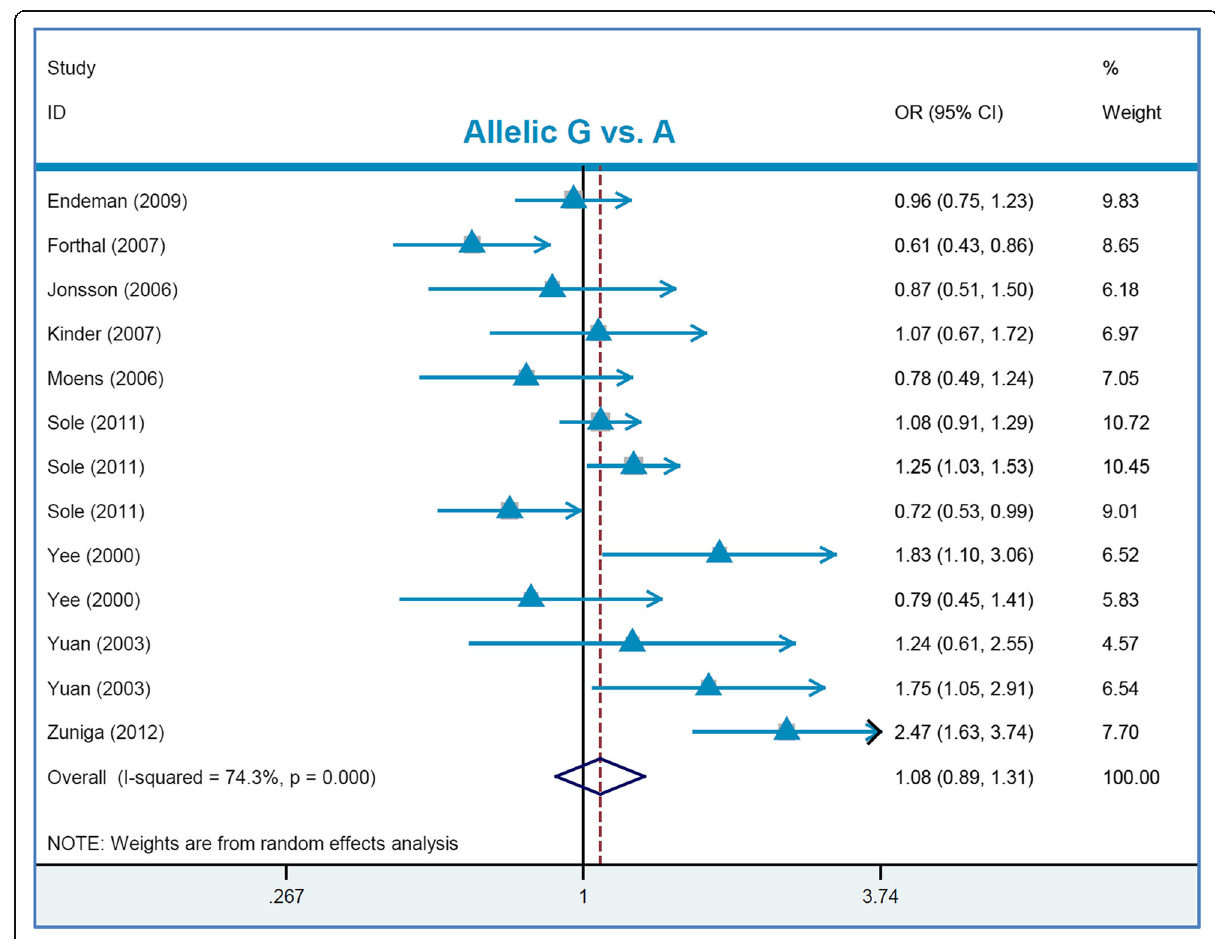
Fig. 2 Forest plot of FCGR2A rs1801274 under the allelic